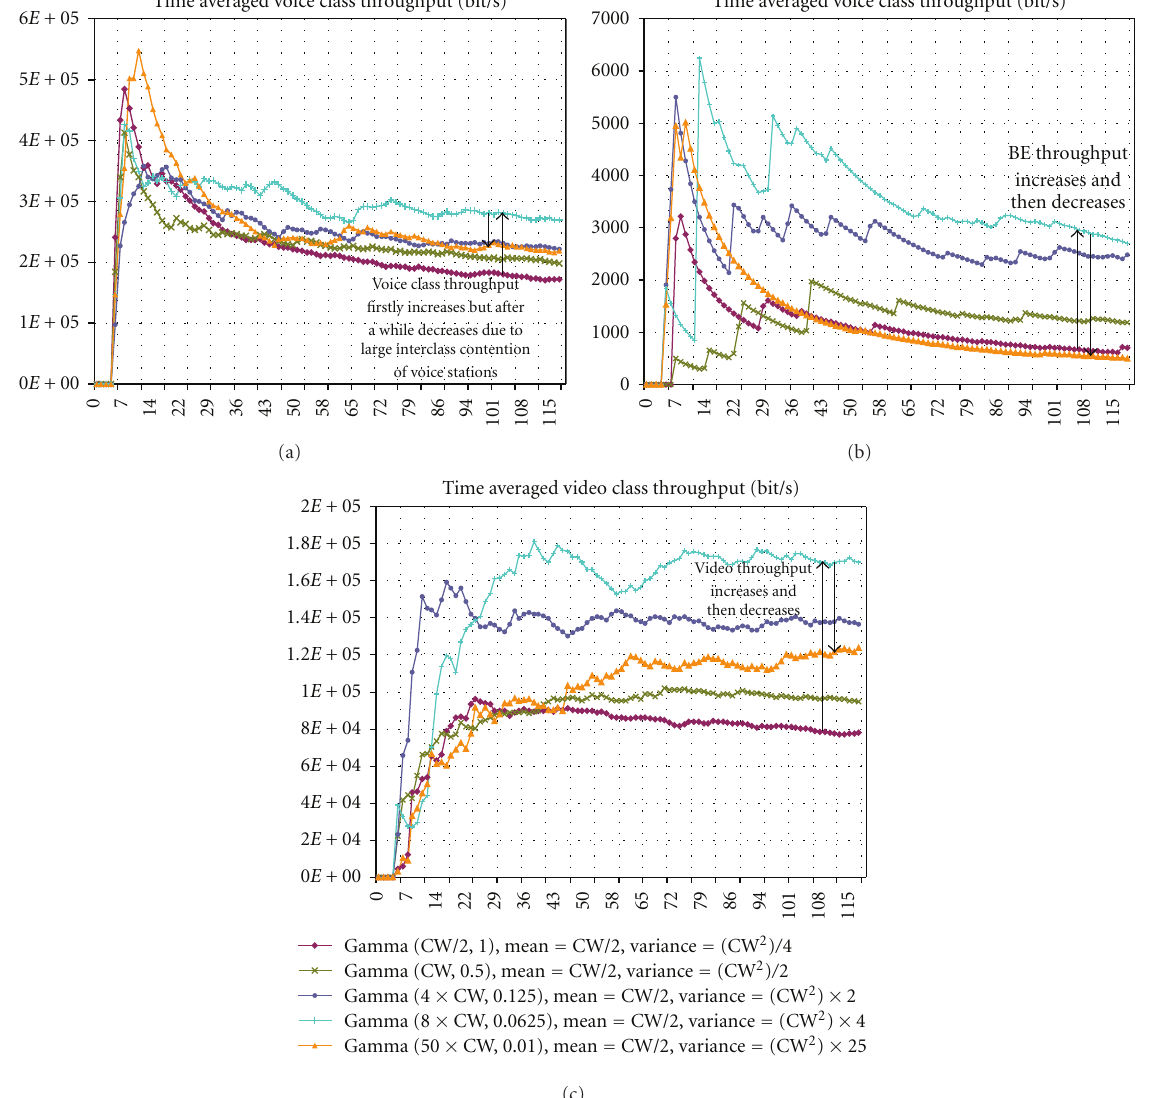
Figure 11: Throughput trends of voice, video, and best e ff ort classes for five di ff erent scenarios ( n = 24). In all these three classes, with PDF variance increment, throughput firstly increases (gets better) and after a threshold decreased (gets worse).